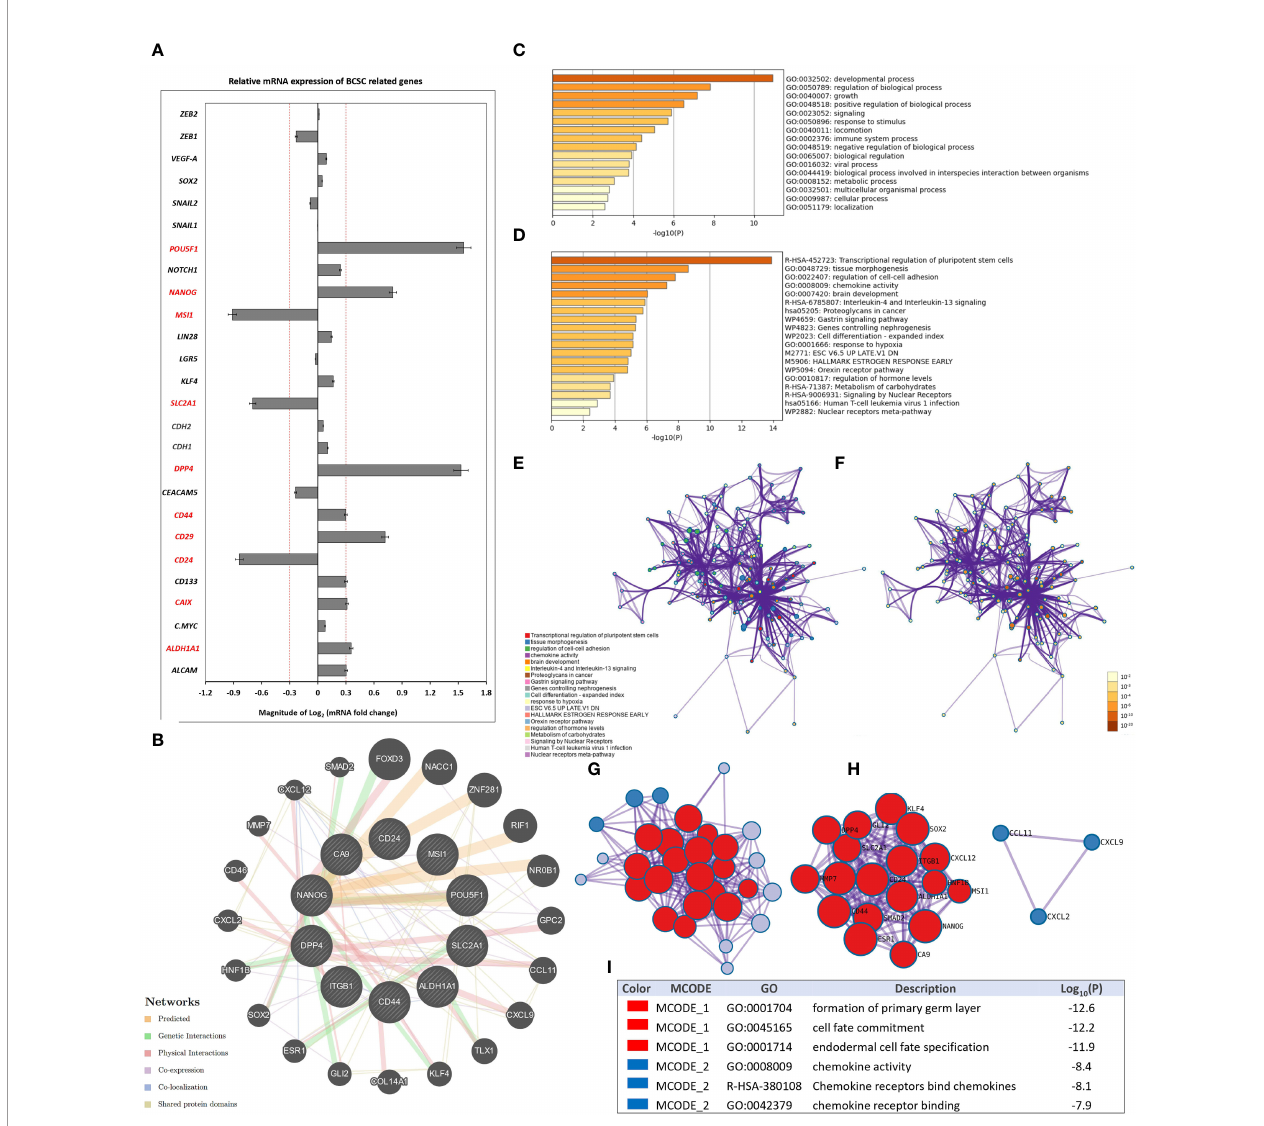
FIGURE 5 | Secretome of HCMV + TAMs enhance the expression of BCSC-related genes in SUM149 cells. (A) Clustered bars represent the mRNA expression of BCSC-related genes in SUM149 cells stimulated by the secretome of HCMV - and HCMV + TAMs compared to mock cells. Data represent the mean of ± SD (number of experimental replicates = 3). P < 0.05 consider signi fi cant as calculated using Student t -test. (B) Gene-gene interaction network of upregulated BCSC-related genes and their neighboring genes. Each node represents a gene, and the size of which represents the strength of the interaction. (C) Bar graph of the top-level Gene Ontology biological processes, colored by P -values. (D) Bar graph of enriched terms across input gene lists, colored by P -values. (E, F) Network of enriched terms: fi rstly colored by cluster ID, where nodes that share the same cluster ID are typically close to each other; secondly colored by p-value, where terms containing more genes tend to have a more signi fi cant P -value. (G, H) Protein-protein interaction network and MCODE components identi fi ed in the gene list. (I) Table showed the functional analysis of MCODE1 and MCODE2